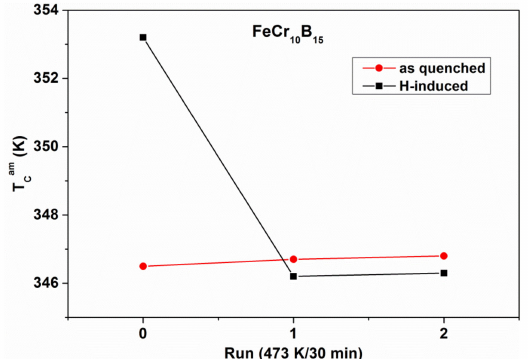
Figure 39. Monitoring of the H desorption in a Fe 75 Cr 10 B 15 glassy alloy during repeated Curie temperature T Cam measurements. Adopted from [133], with permission from the Institute of Physics of the Polish Academy of Sciences,